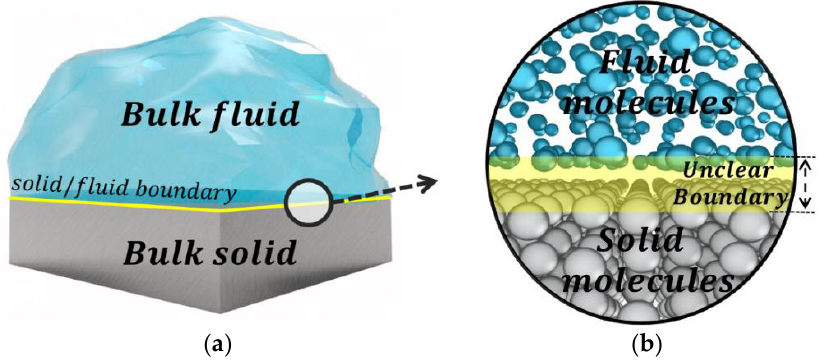
Figure 1. A pictorial representation of solid / fluid boundary at ( a ) the macroscopic scale; ( b ) the molecular scale.